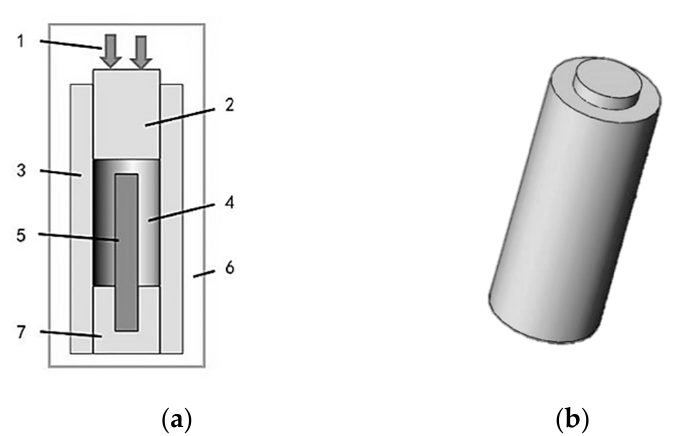
Figure 1. Tungsten carbide (WC)/high-speed steel composite preparation mold. ( a ) Parts of the mold are: 1, pressure; 2, upper punch; 3, pressing die body; 4, mixed material powder; 5, high-speed steel core; 6, shielding gas; 7, stationary punch. ( b ) Three-dimensional mold diagram.